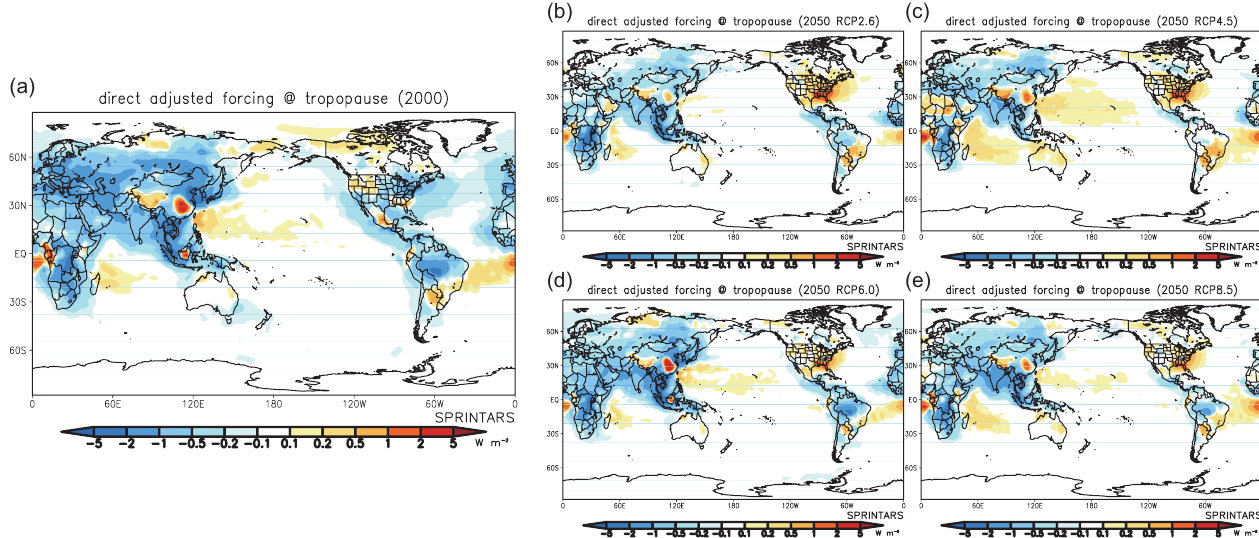
Fig. 8. Global distributions of adjusted forcing due to the aerosol direct effect at the tropopause in (a) 2000 (averaged over the period 1998–2002) and (b) – (e) 2050 (averaged over the period 2048–2052) for the four RCPs relative to the preindustrial experiment simulated by SPRINTARS. Table 1. Global mean adjusted forcing (in Wm − 2 ) due to the aerosol direct effect at the tropopause and surface in each decade (5-yr running mean) relative to the preindustrial experiment simulated by